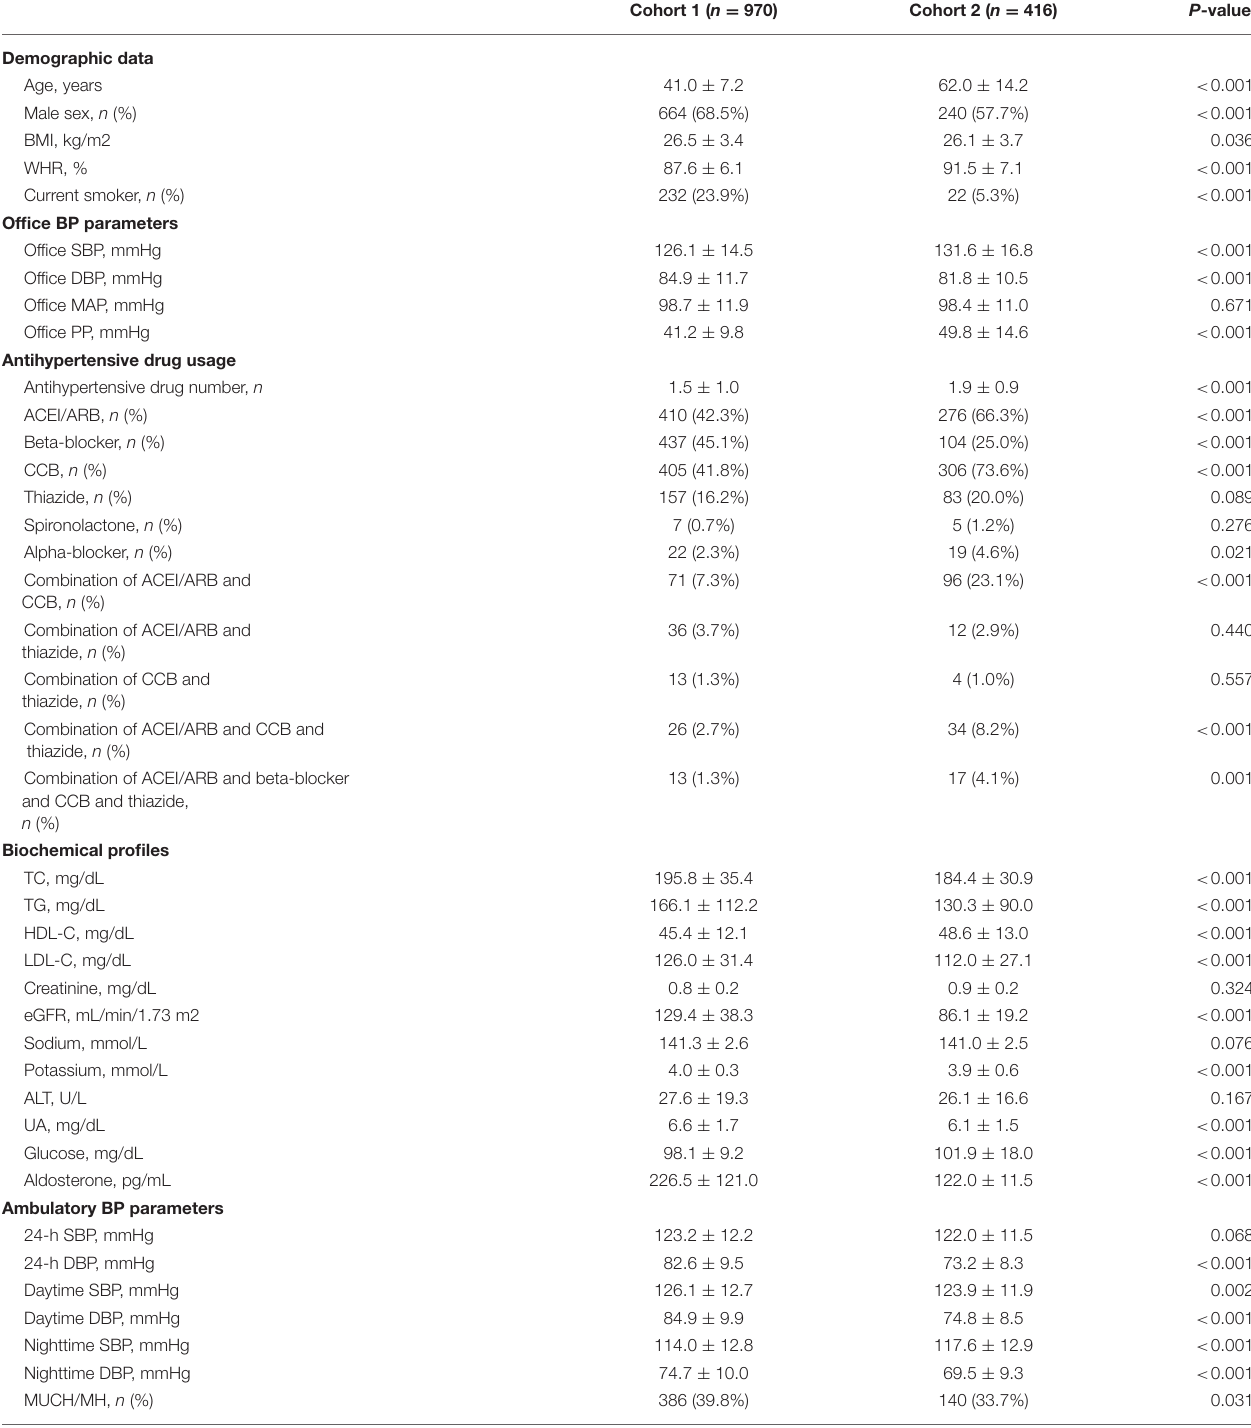
TABLE 1 | Baseline characteristics and the proportion of MH/MUCH in the two